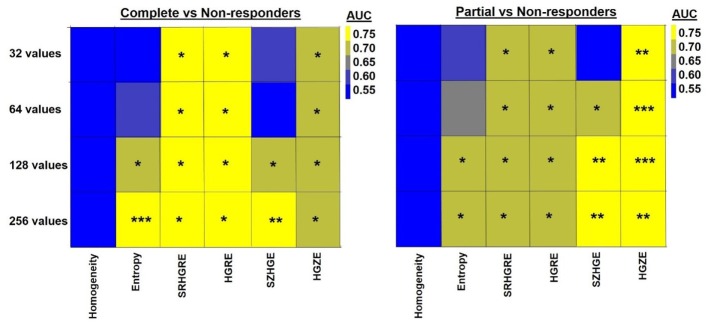
Heatmap shows the quantification (AUC) of the relationship between ΔTexture and pathologic response computed with 32, 64, 128, and 256 discrete values. * indicates 0.005 < p < 0.05, ** indicates 0.0005 < p < 0.005, *** indicates p < 0.0005. HGRE, high-gray-run emphasis; HGZE, high-gray zone-run emphasis; SRHGRE, Short-run high-gray-run emphasis; SZHGE, short-zone high-gray-run emphasis.